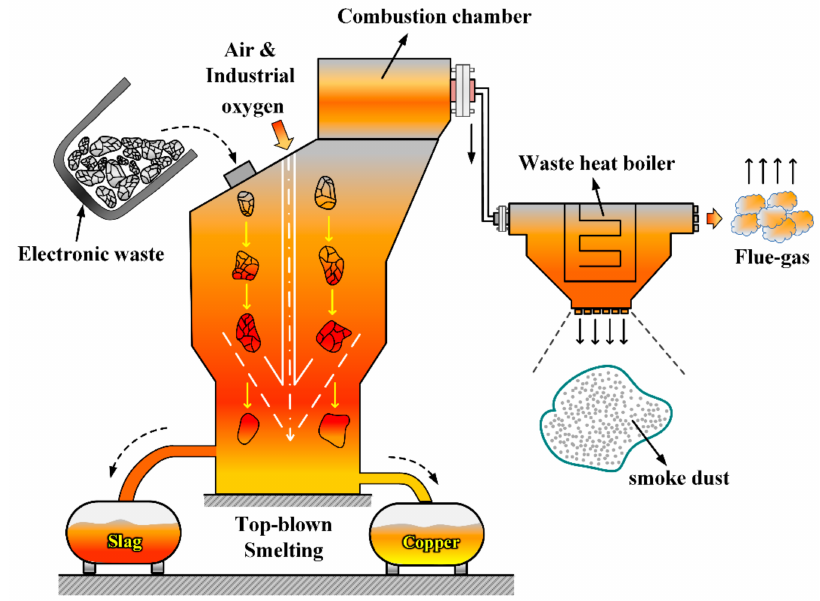
Figure 1. The sketch diagram of the top-blowing smelting system of electronic